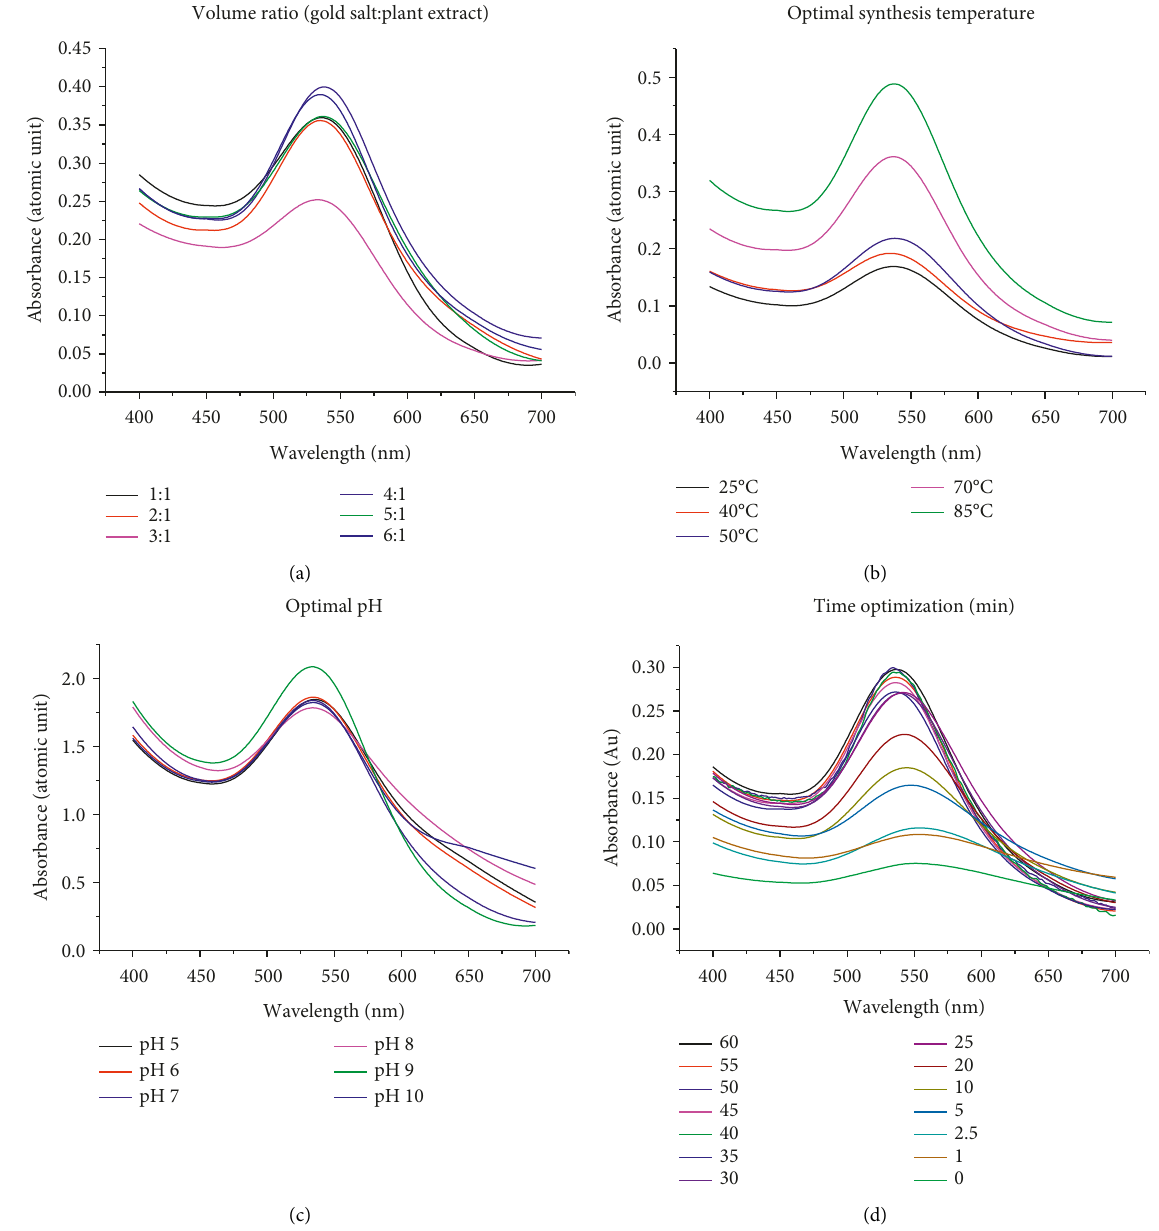
Figure 2: UV-Vis spectra for (a) concentration course, (b) temperature course, (c) pH course, and (d) time course for synthesis using Physalis